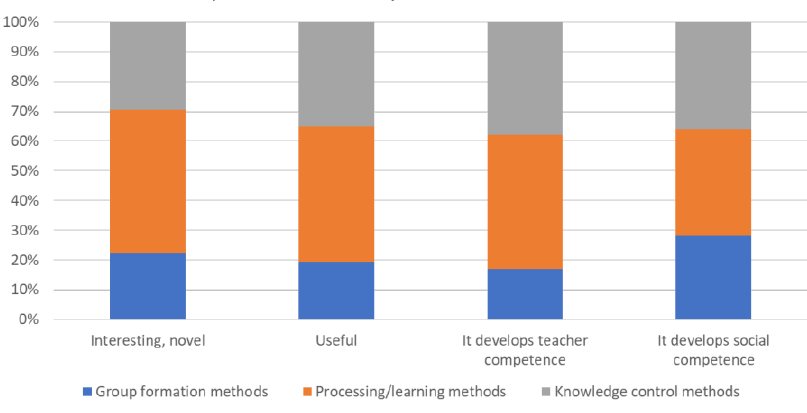
Fig. 3. Opinions on the cooperative methods used in the